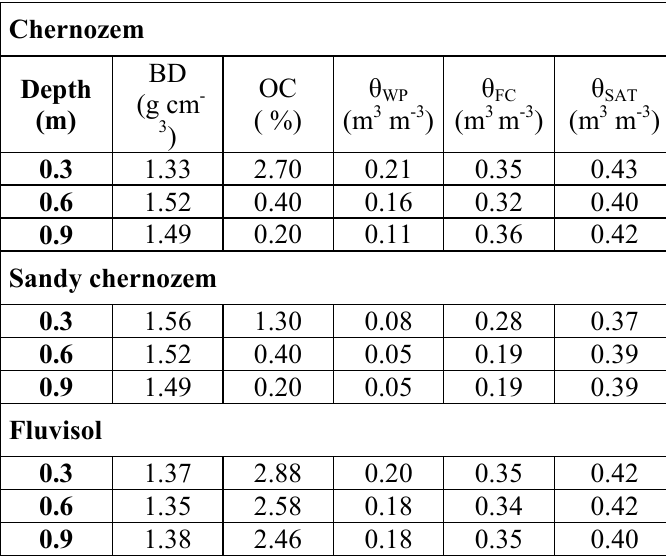
Table 2. Overview of measured and derived* soil parameters in the three top profiles that were used as crop model inputs: bulk density (BD), organic carbon content (OC), soil water content at the saturation point ( θ ), field capacity ( θ ) and wilting point ( θ ). SAT FC WP